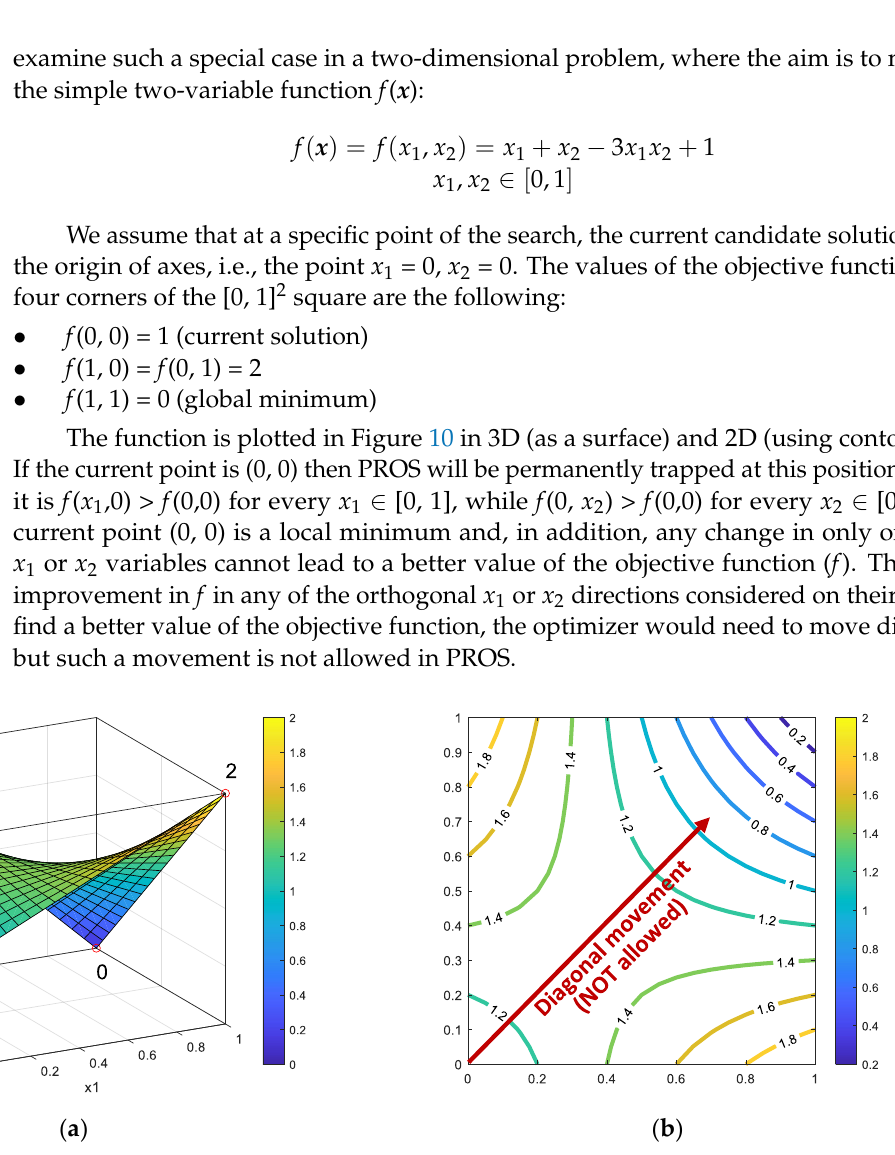
Figure 10. The objective function f ( x 1 , x 2 ) = x 1 + x 2 - 3∙ x 1 ∙ x 2 +1, plotted in [0, 1] 2 . PROS is trapped at the local minimum (0, 0) since there is no improvement in f in any of the x 1 or x 2 directions on their own: ( a ); 3D surface plot and ( b ) 2D contour plot.